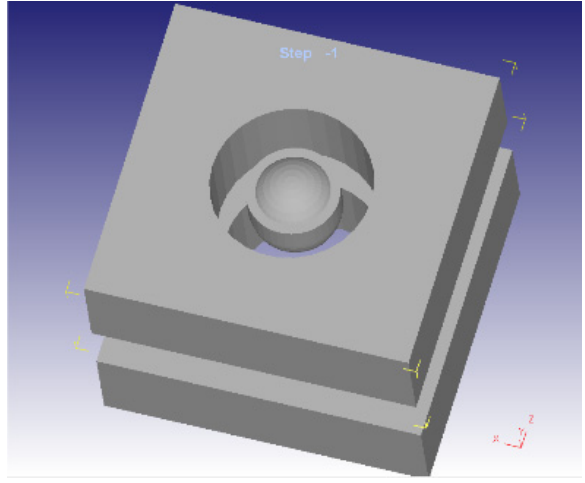
Figure 4. Mode of impactor head and structure of clamping plates. Table 3. Working parameters.